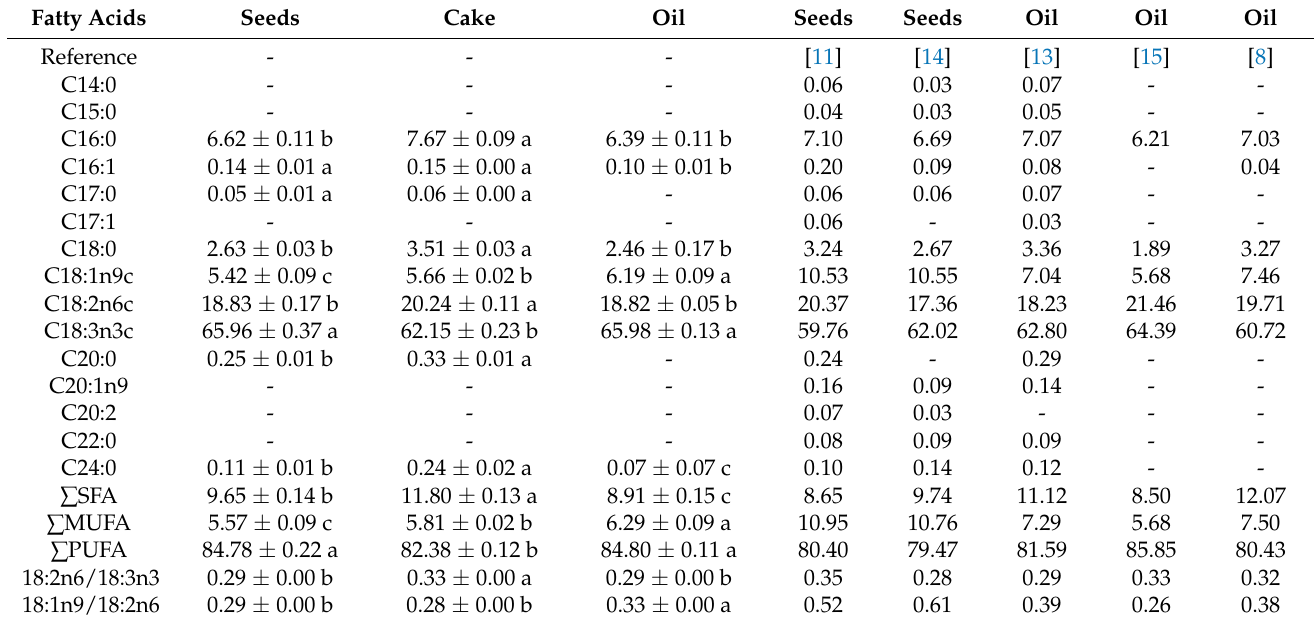
Table 2. Fatty acids profile of chia seeds, cake, oil, and literature